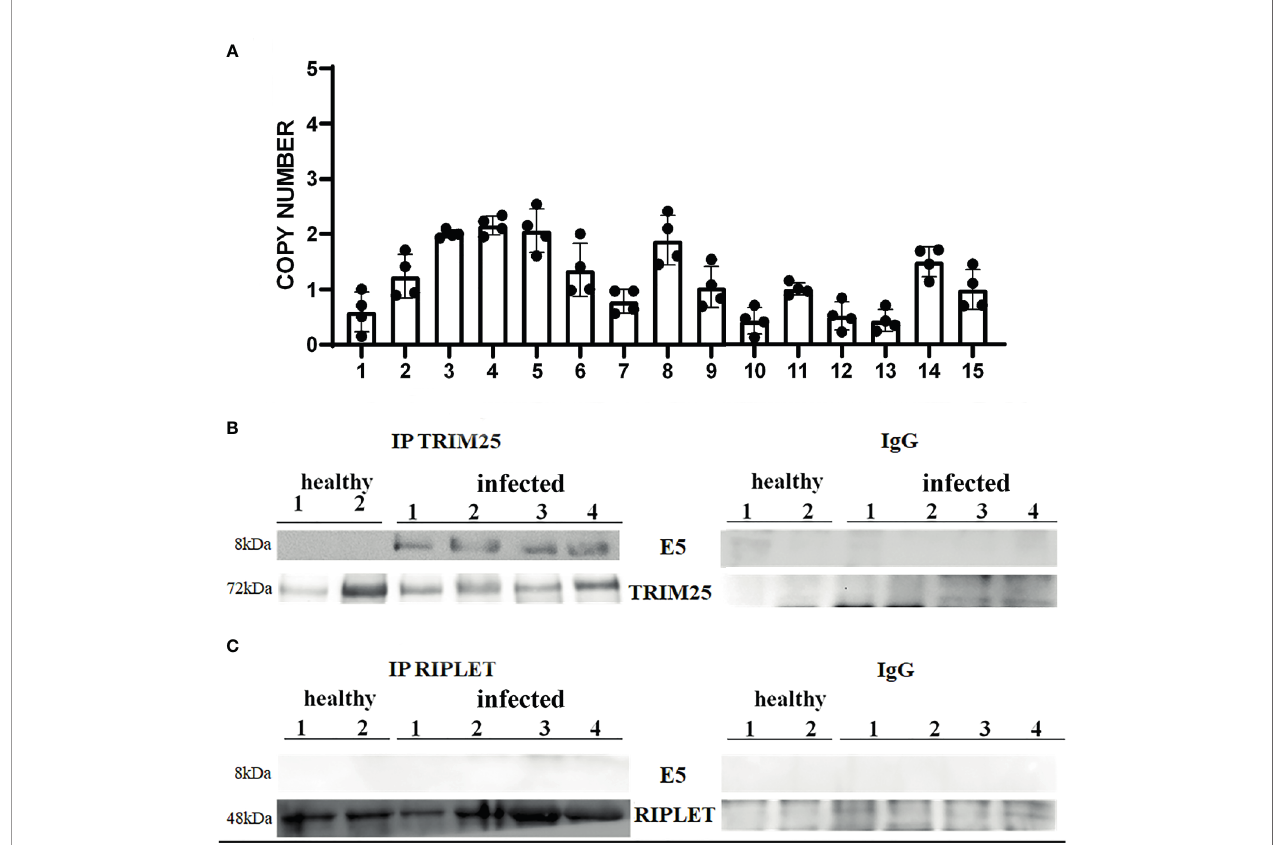
FIGURE 1 | (A) Copy number of BPV E5 mRNA by one-step RT-ddPCR analysis detected in 15 bladder tumours. Each plot represents an independent experiment. Statistical analysis revealed no signi fi cant differences in copy number of BPV E5 mRNA of each analysed bladder tumours. (B, C) showed immunoprecipitation assay using anti-TRIM25 and anti-Riplet antibodies, respectively, in healthy and infected bladder samples. Western blot analysis revealed that TRIM25 only interacted with E5 protein. Panels (B, C) show representative data from three independent